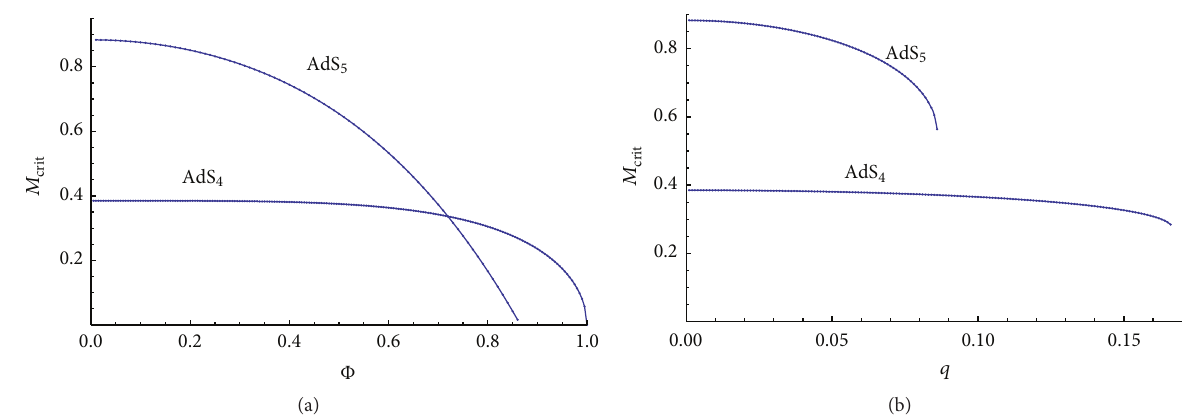
Figure 9: The critical energy to produce (a) a pBH for the fixed potential case and (b) a pBH3 for the fixed charge case.